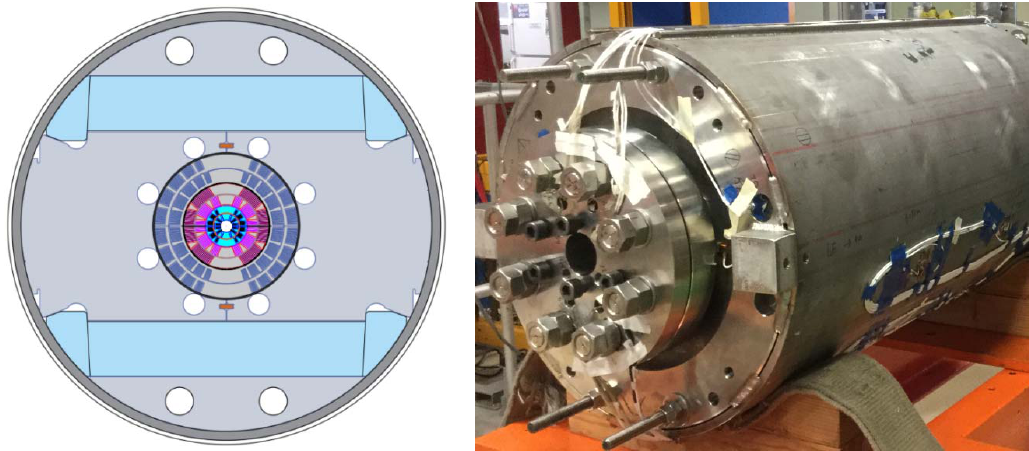
Figure 11. Cross ‐ section of six ‐ layer hybrid dipole coil inside MDPCT1 dipole structure ( left ); a Figure 11. Cross-section of six-layer hybrid dipole coil inside MDPCT1 dipole structure ( left ); a picture picture of the MDPCT1 dipole with 4 ‐ layer Nb 3 Sn coil inside ( right ). of the MDPCT1 dipole with 4-layer Nb 3 Sn coil inside ( right ).